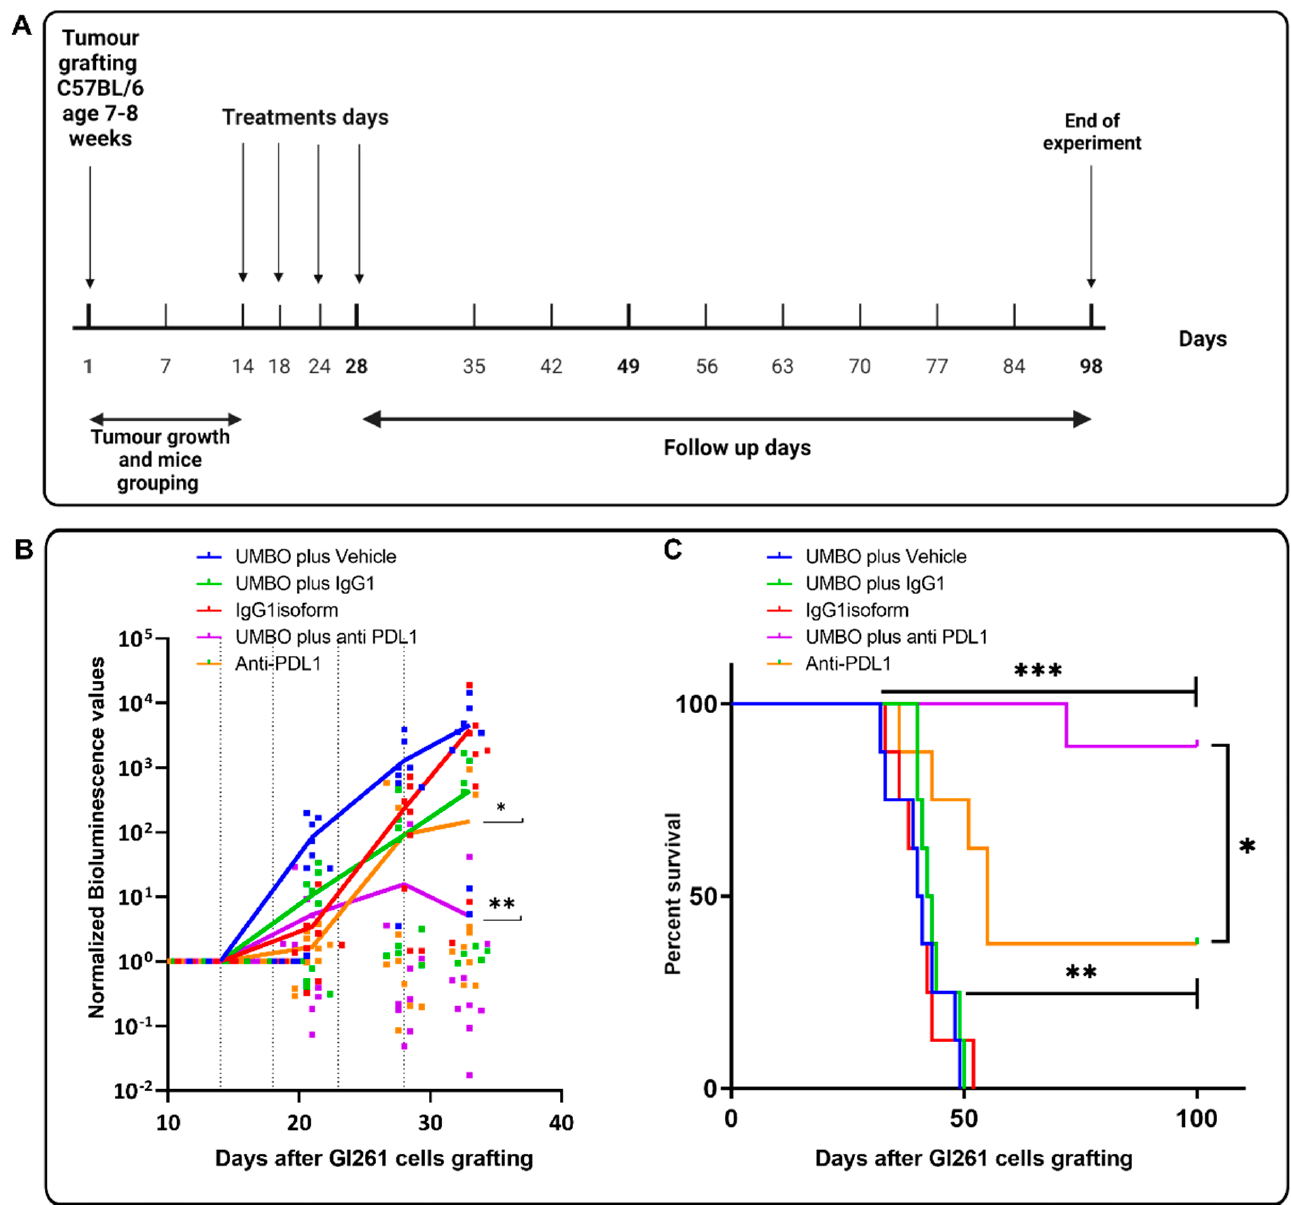
Figure 3. UMBO increased the efficacy of anti-PD-L1 in GL261-bearing mice. (Panel A ): shows a timeline of the treatment protocol used in the survival experiments. Cell grafting was done on day 1 while treatments were applied on days 14, 18, 24, and 28. Mice were followed up for 100 days. (Panel B , C ): (Panel B ): bioluminescence normalized to the first measured value after cell inoculation in GL261-bearing mice. Each dot represents values for one animal and the line represents the median value for the group. Bioluminescence signal was measured weekly. Dotted lines represent the days of treatments. Anti PD-L1 plus UMBO suppressed tumor growth over time compared to controls.